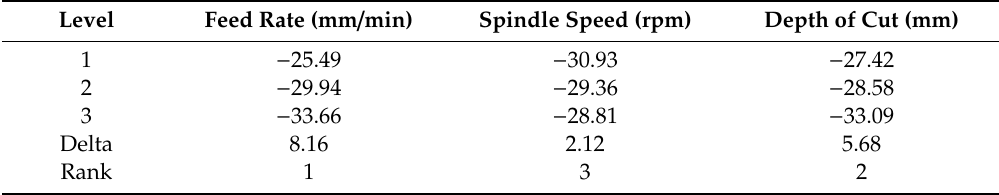
Figure 7. Measurement area of the cutting force and surface roughness. Table 5. Response table mean S / N ratio for the cutting force, according to the machining conditions.